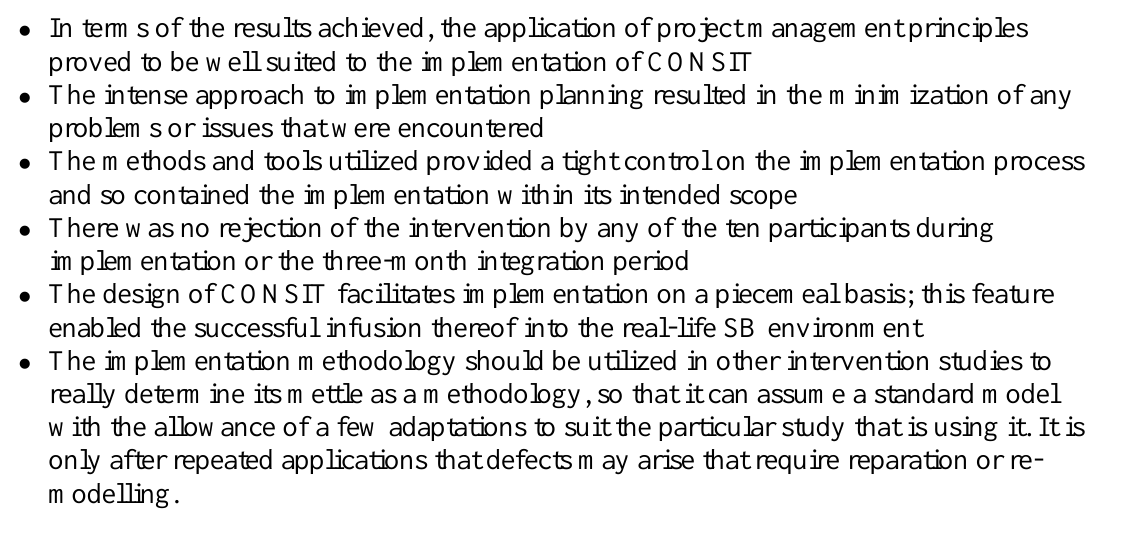
Table 1 Performance variable